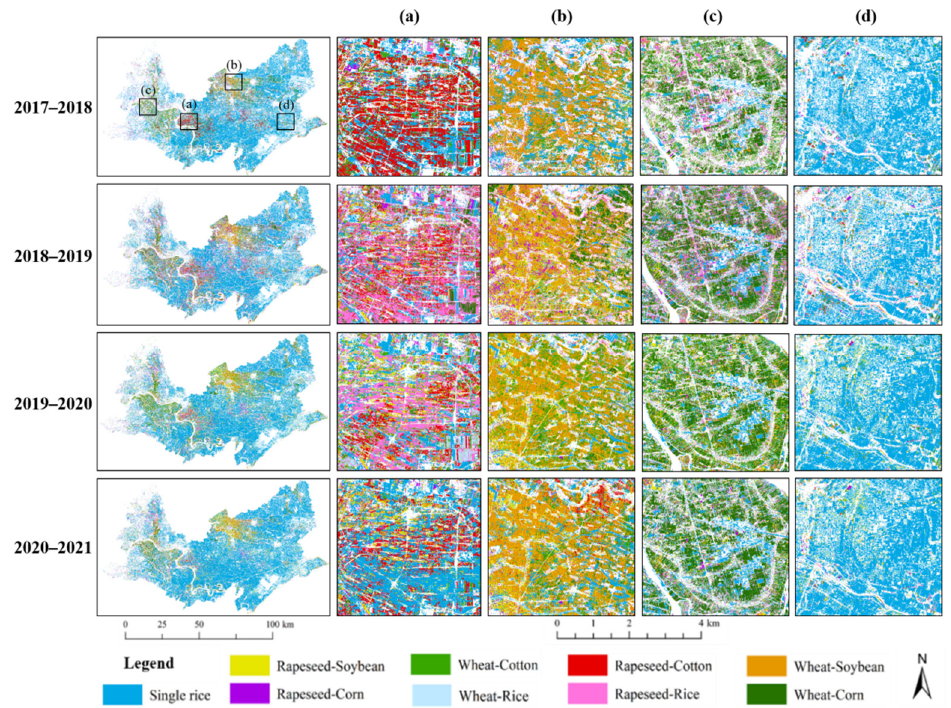
Figure 9. Spatial distribution of planting pattern in each year.(( a – d ) are the detail areas showed in the figure of the study area).